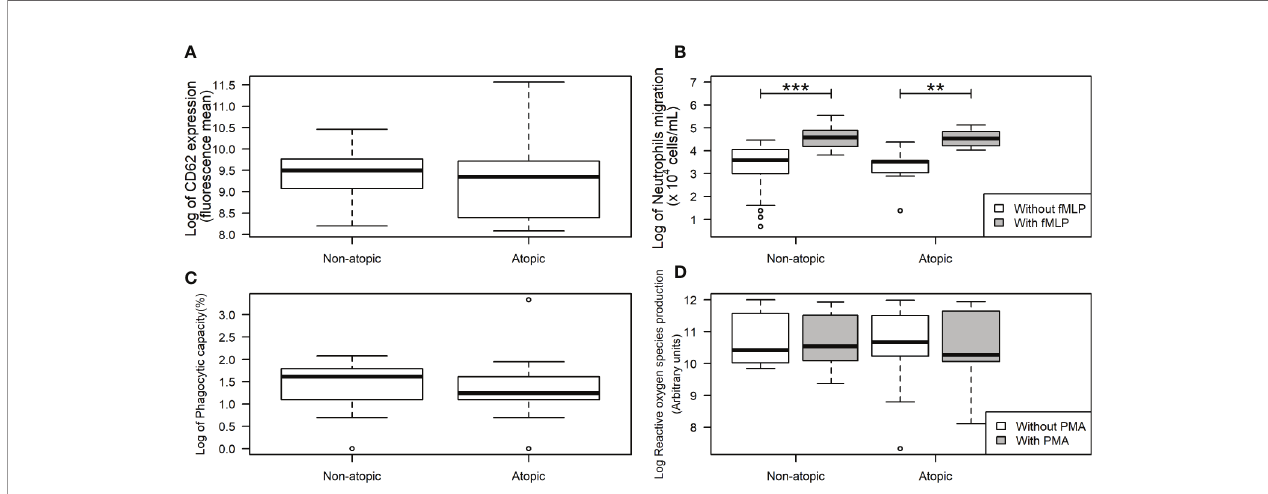
FIGURE 1 | L-Selectin expression and functions in neutrophils from non-atopic and atopic runners. Neutrophils were obtained from the bloodstream of non-atopic and atopic runners at rest, and L-selectin (CD62L) expression on the neutrophil surface (A) , migration (B) , phagocytic capacity (C) , and reactive oxygen species production (D) were assessed. The results are presented as medians (middle lines). The 25 – 75% con fi dence intervals (closed boxes) and the 5 – 95% con fi dence intervals (lower and upper lines, respectively) are indicated. ***p < 0.0001 when compared to neutrophils (in the absence of fMLP) of non-atopic runners. **p < 0.01 when compared to neutrophils (in the absence of fMLP) of atopic runners.